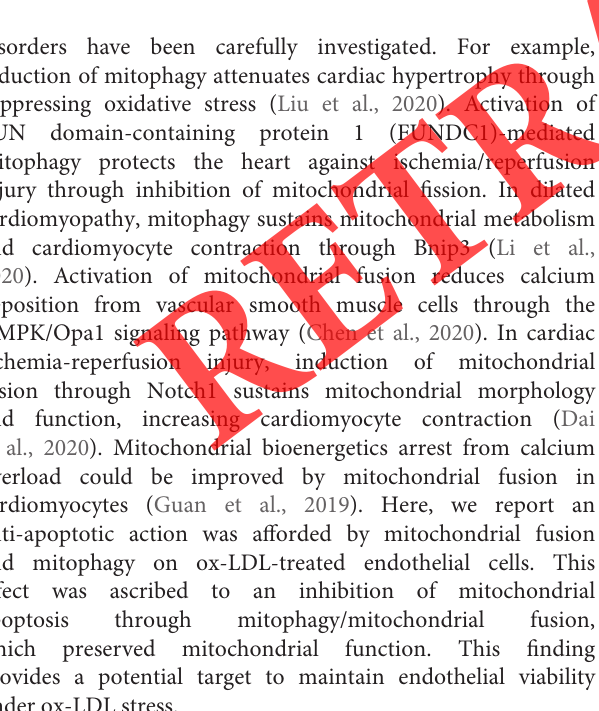
FIGURE 5 | Overexpression of Opa1 restores endothelial cell viability and reduces apoptosis after ox-LDL treatment by modulating mitophagy and mitochondrial fusion. (A) Cell viability was determined through the CCK8 assay. siRNAs against mitophagy (Atg5) and mitochondrial fusion (Mfn2) were transfected into Opa1-overexpressed endothelial cells. (B,C) An ELISA was used to observe the activity of caspase-3 and caspase-9. (D) A JC-1 probe was used to observe the mitochondrial membrane potential in endothelial cells after exposure to ox-LDL. (E) Mitochondrial ROS production in ox-LDL-treated endothelial cells was measured through immunofluorescence. * p <